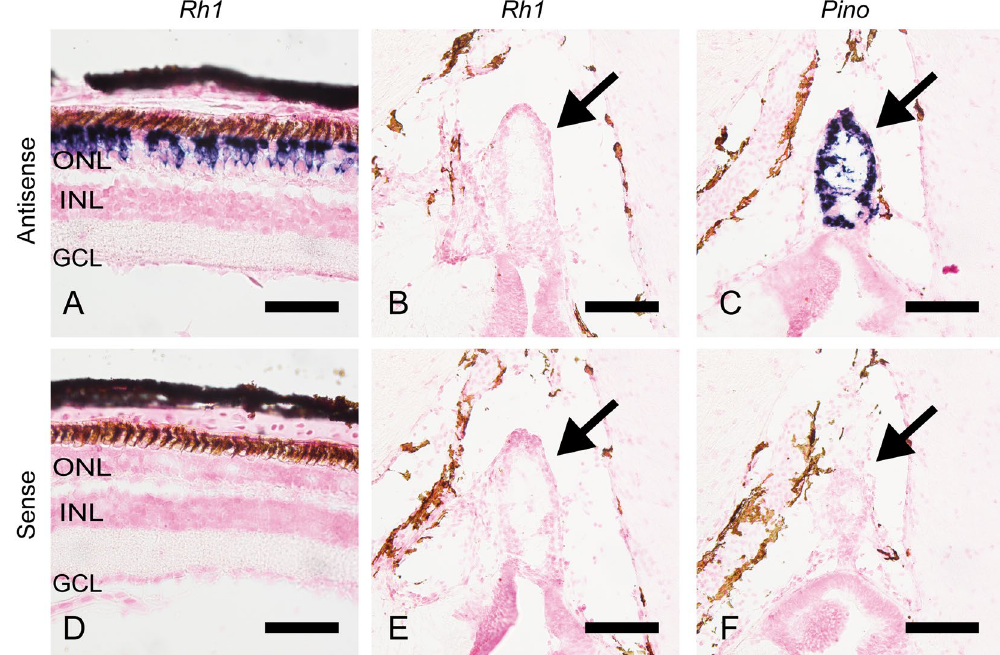
Figure 3. Distribution of rhodopsin in the retina and the pineal gland of gray bichir. In situ hybridization of rhodopsin ( Rh1 ) and pinopsin ( Pino ) in the retina and the pineal gland of gray bichir. The section of the retina was hybridized with antisense probe of Rh1 ( A ). The frontal sections of the pineal gland were hybridized with antisense probes of Rh1 ( B ) and Pino ( C ), respectively. ( D–F ) show the consecutive tissue sections to ( A – C ) hybridized with corresponding sense probes, respectively. Allows indicate the position of the pineal gland. All the sections shown in this figure were counterstained with Nuclear Fast Red. Scale bar: ( A , D ) 50 μ m; ( B , C , E , F ) 100 μ m. ONL, outer nuclear layer; INL, inner nuclear layer; GCL, ganglion cell